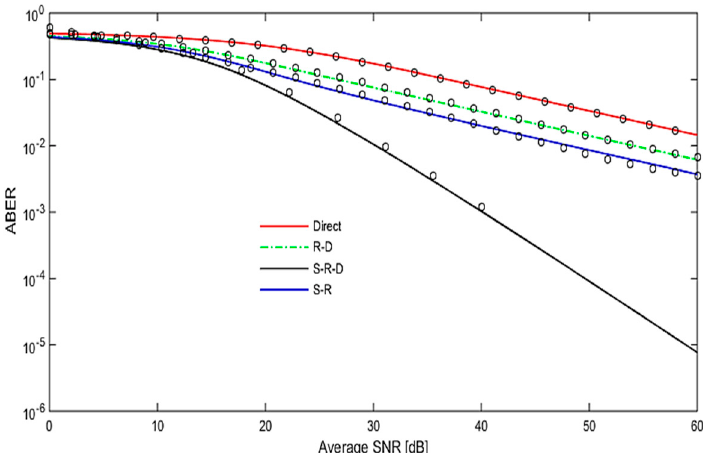
Figure 10. ABER vs. SNR of FSO over L-N channel for moderate turbulence with distance 600–400 m, the number of relays = 3, and w z = 0.5 m.